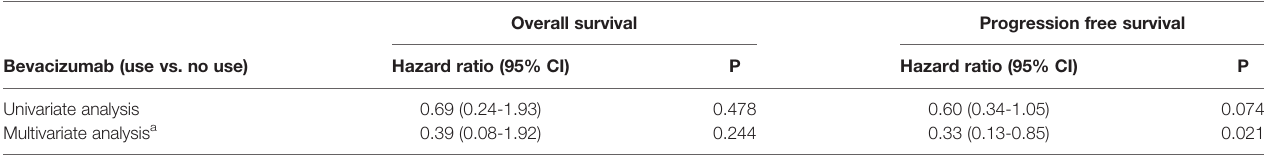
TABLE 2 | Associations of Bevacizumab treatment for recurrent disease with overall and progression free survival. Overall survival Progression free survival